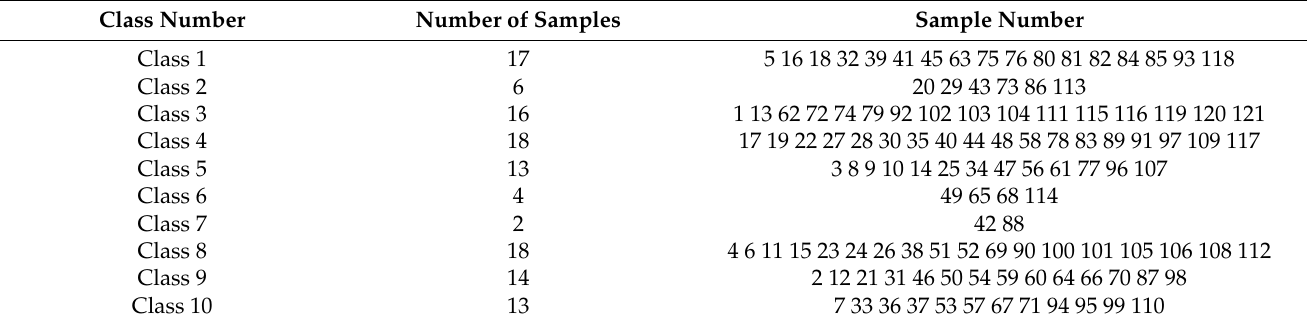
Table 3. K-means clustering results.